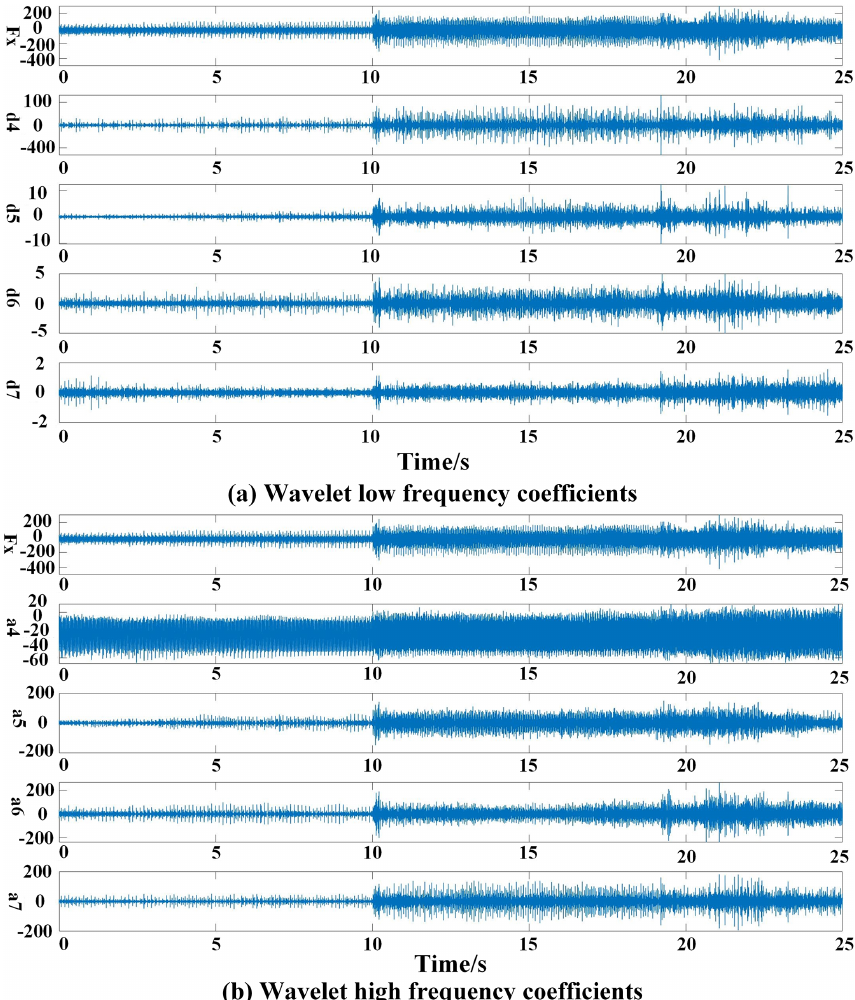
Figure 8. Decomposition diagram of wavelet